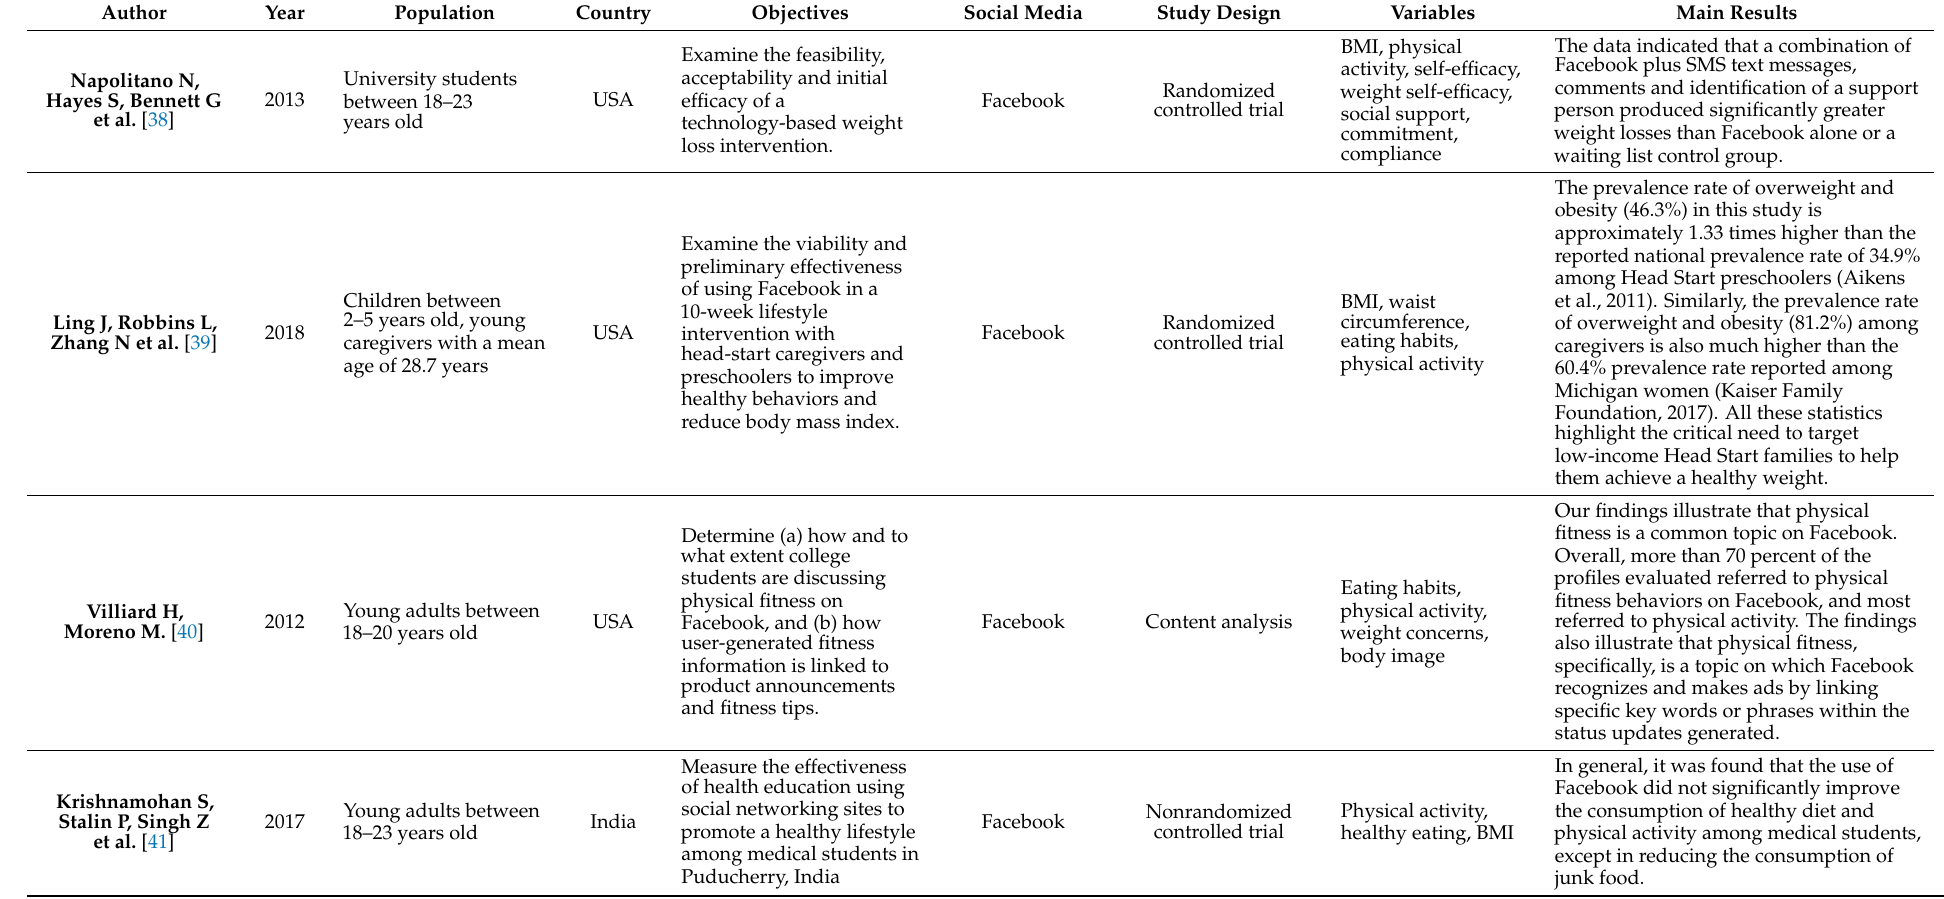
Table 1. Characteristics of studies included in the review, objectives and main